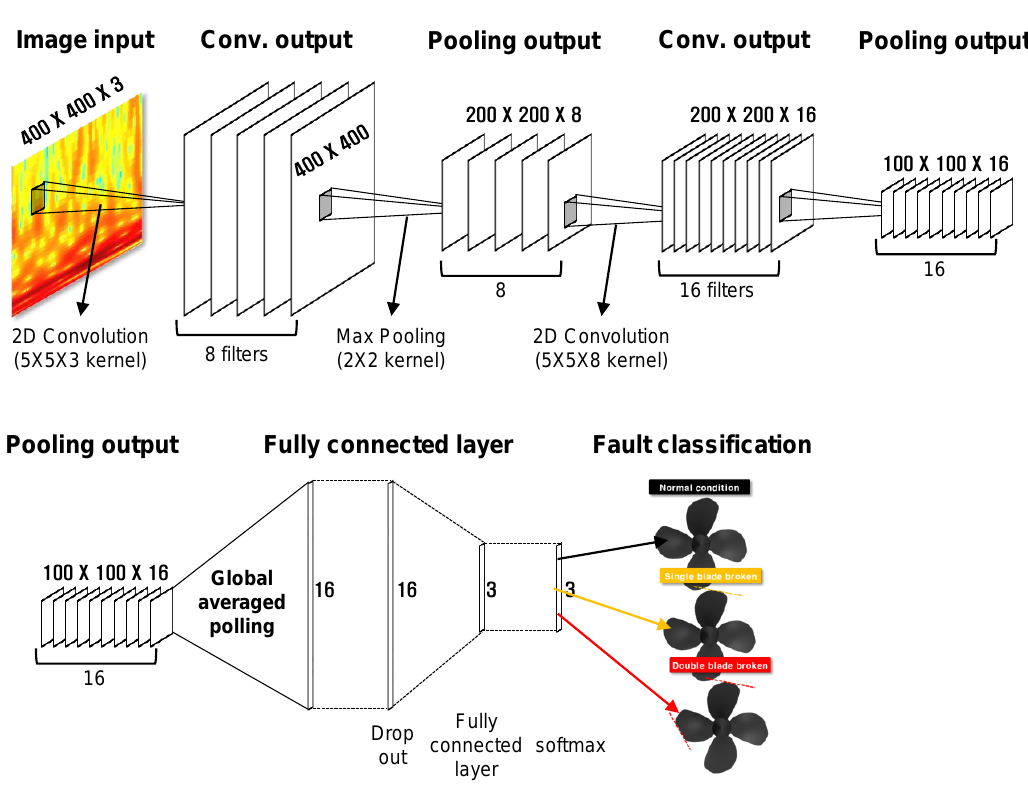
Figure 7. CNN architecture for AUV health monitoring. ( top ) Feature extraction; ( bottom )